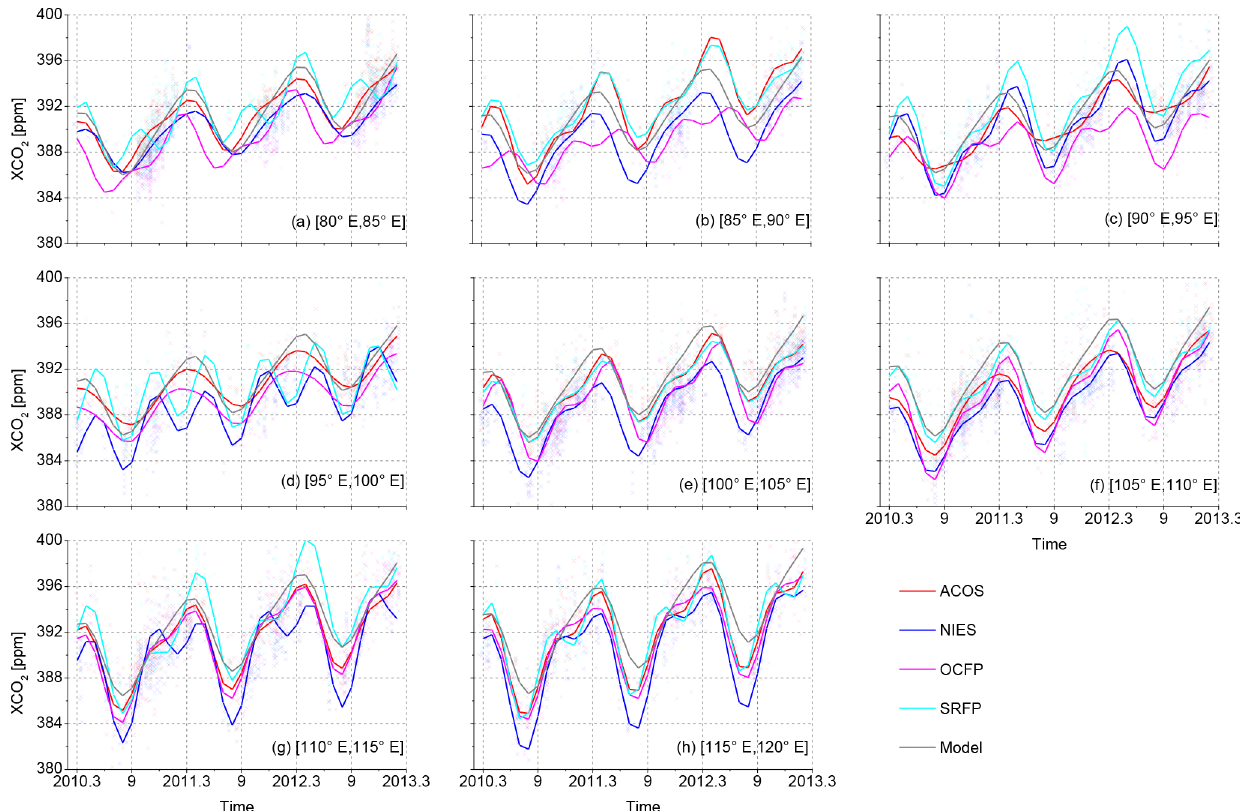
Figure 7. The time series from March 2010 to February 2013 in eight cells from the western cell (a) to the eastern end cell (h) , where colored lines represent the fitting seasonal change trend of the four XCO 2 datasets from the four algorithms, and the colored points represent single XCO 2 retrievals corresponding to four algorithms according to line color: red is for ACOS, blue for NIES, magenta for OCFP and cyan for